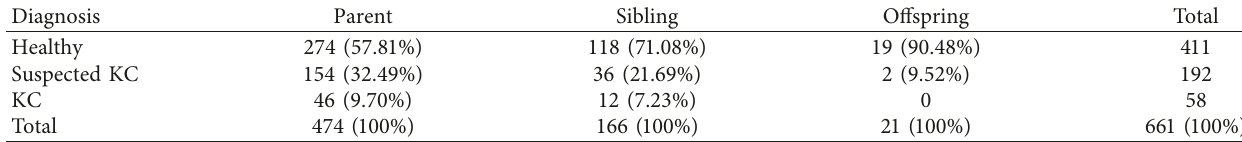
Table 3: Number of people diagnosed with keratoconus in different family relationship